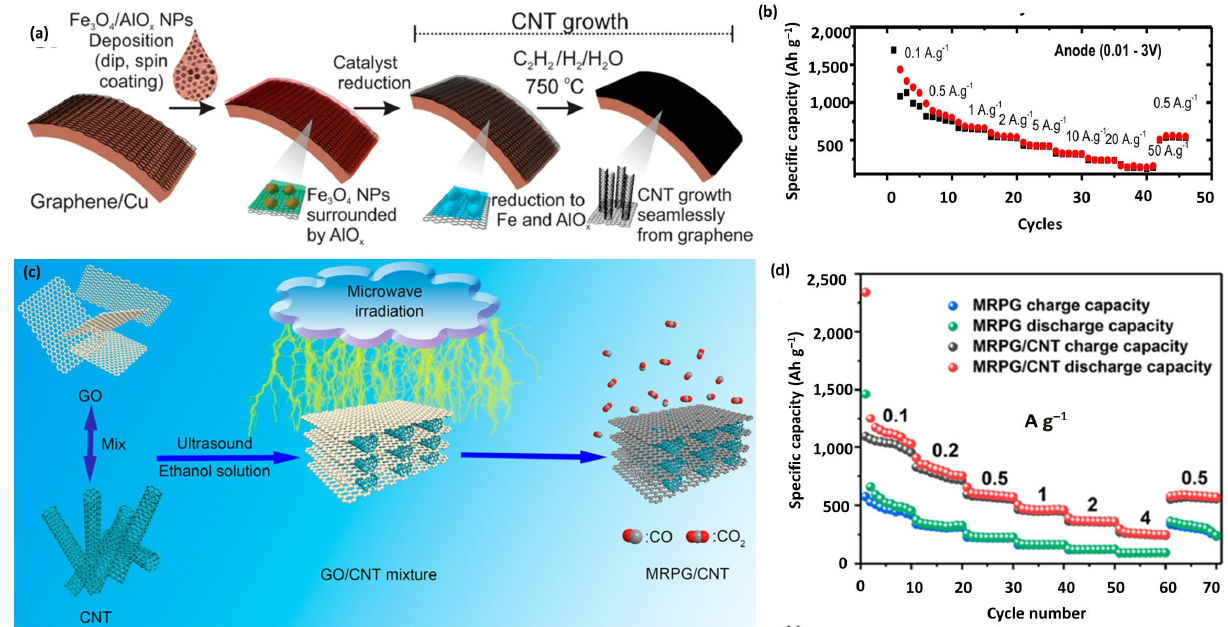
Figure 10. ( a ) Scheme for the growth of GCNT hybrid materials; ( b ) Rate testing of GCNT. Repro- duced with permission from Ref. [137]. Copyright 2017, American Chemical Society. ( c ) Schematic illustration of the synthesis process of MRPG/CNT; ( d ) Rate performance of MRPG and MRPG/CNT. Reproduced with permission from Ref. [71]. Copyright 2019, American Chemical So- ciety.